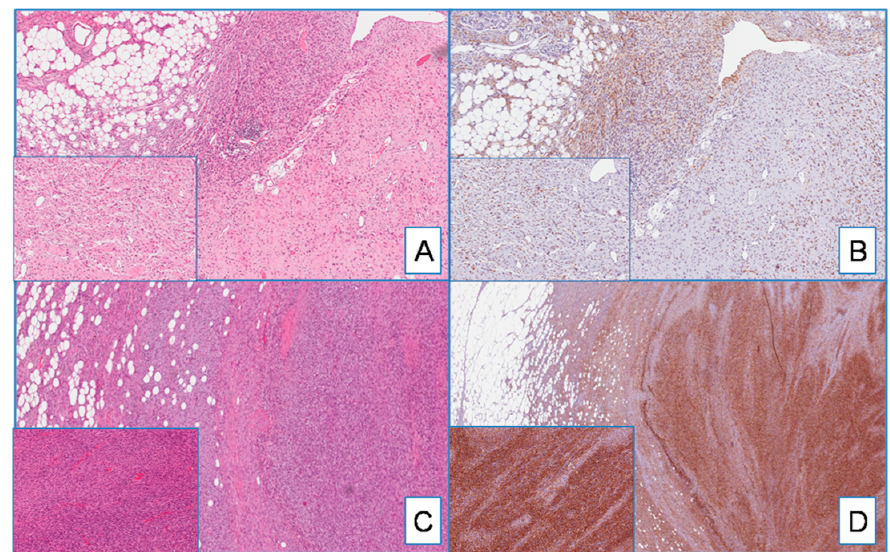
Figure 2. ( A ) DFSP with giant cell fibroblastoma component (on the right and insert) (H&E; origi ‐ nal magnification 50×); ( B ) serial section showing diffuse cytoplasmatic staining for WT1 in both classic ‐ type and giant cell components (insert) (immunoperoxidase; original magnification 50×); ( C ) DFSP with fibrosarcomatous component (on the right and insert) (H&E; original magnification 50×); ( D ) WT1 is diffusely and strongly expressed in both classic ‐ type and fibrosarcomatous com ‐ ponents (insert) (immunoperoxidase; original magnification 50×).